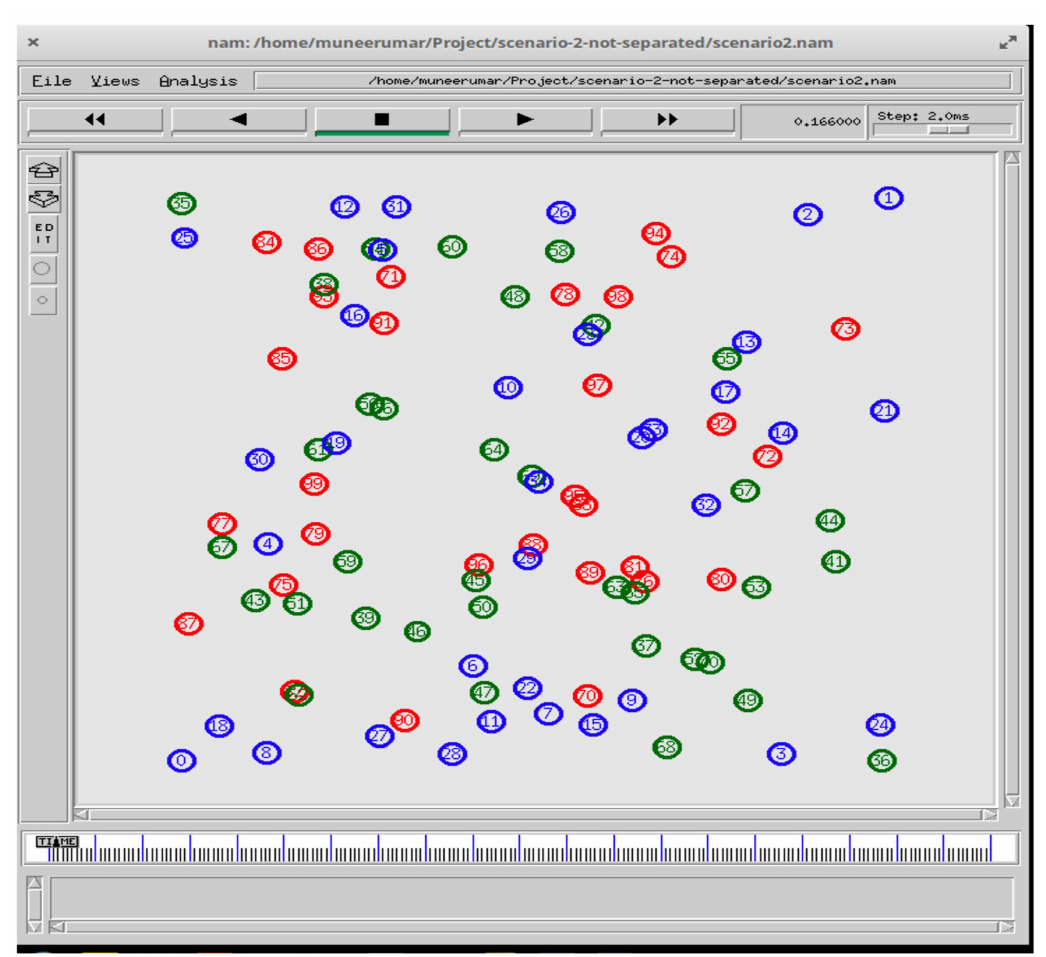
Figure 11. Case scenario 2: NS2 NetAnim Screenshot. The simulation parameters for this experiment are given in Table